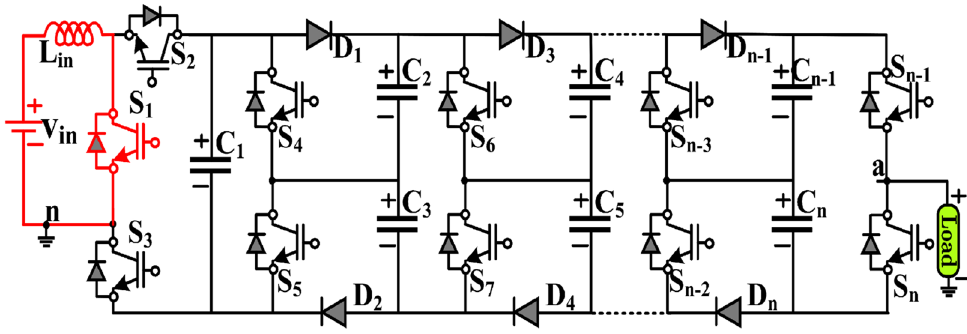
Figure 3. Proposed extended